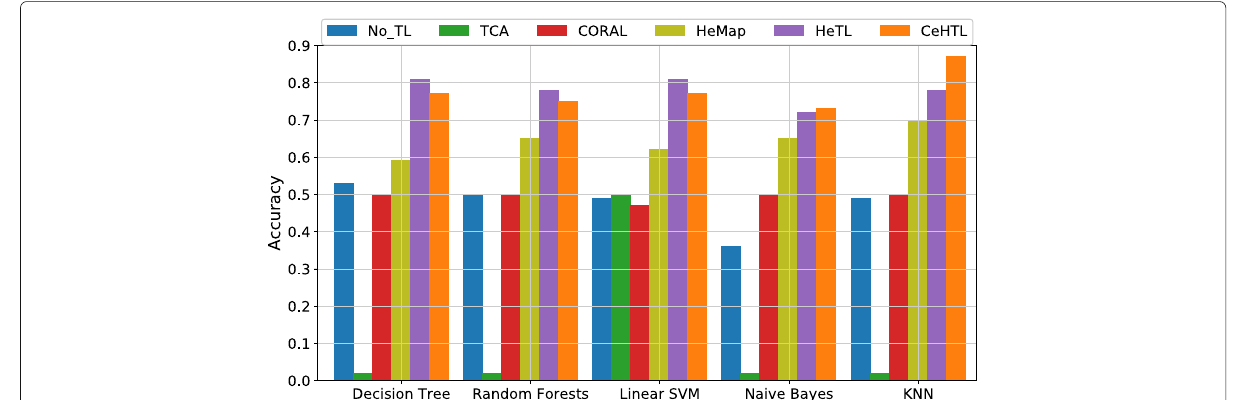
Fig. 7 Performance comparison of feature-based transfer learning approaches on DoS → R2L